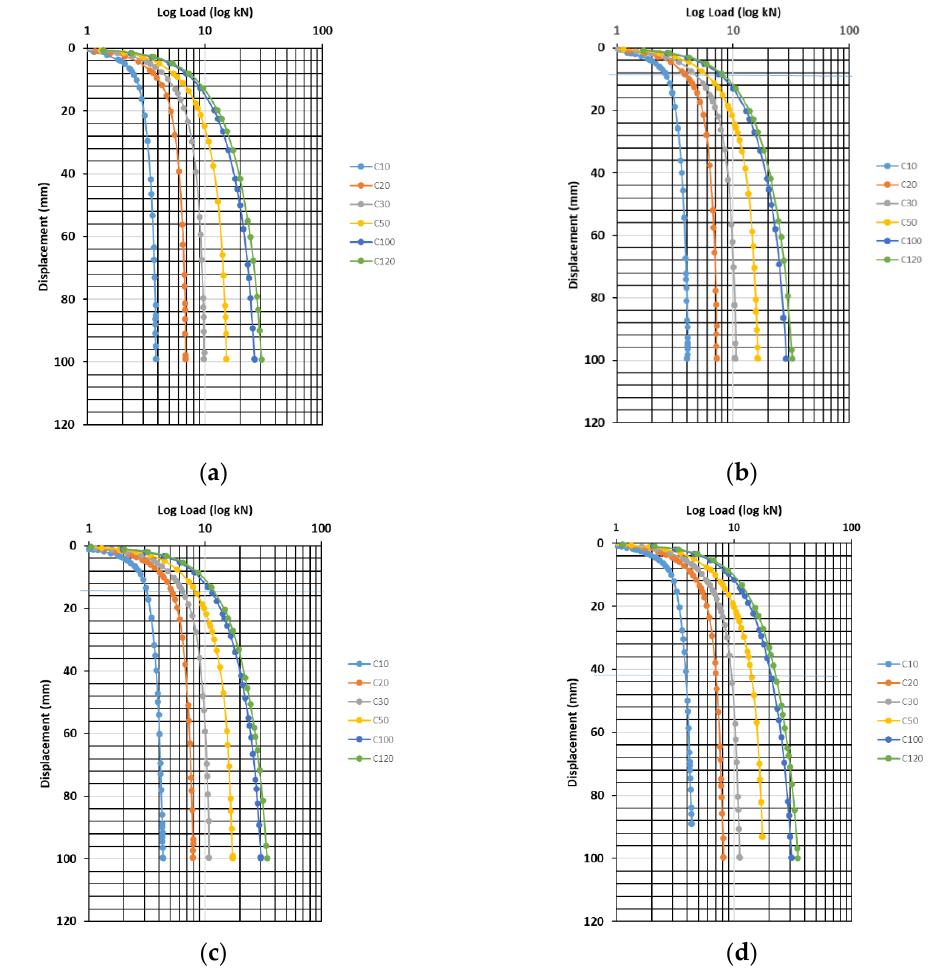
Figure 4. Load versus horizontal displacement for CHSB 0 pile. ( a ) Elasticity modulus of 30 MPa; ( b ) elasticity modulus of 50MPa; ( c ) elasticity modulus of 80MPa; ( d ) elasticity modulus of 100MPa. Table 8. Pile foundation capacity in relation to cohesion of soil for CHSB 0 pile.